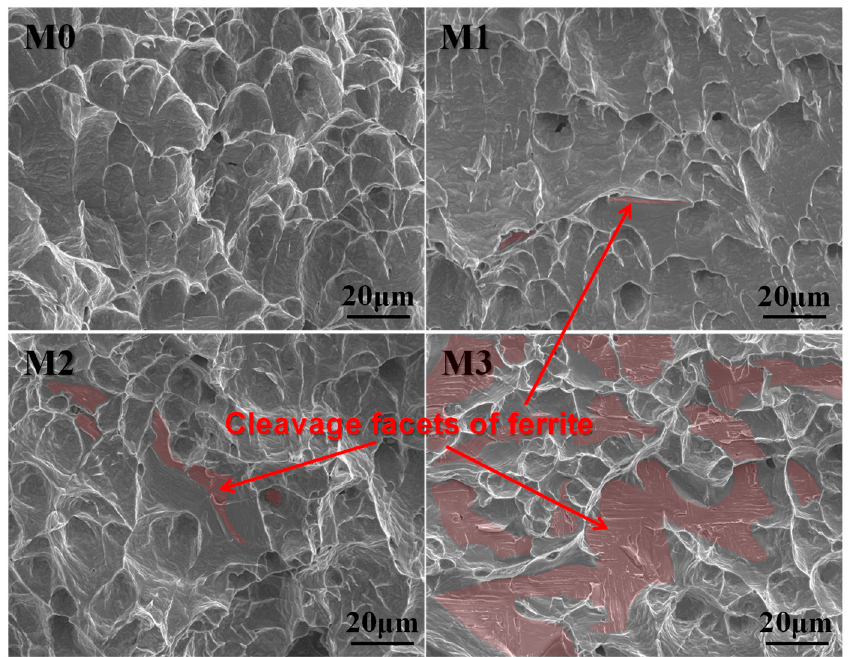
Figure 9. Morphologies of the impact fracture surfaces of the CDSS specimens thermally aged at 400 ◦ C for 3000 h. (M0, M1, M2, and M3 corresponds the alloy with Mo content of 0.0, 0.20, 0.90, and 1.75 wt%,